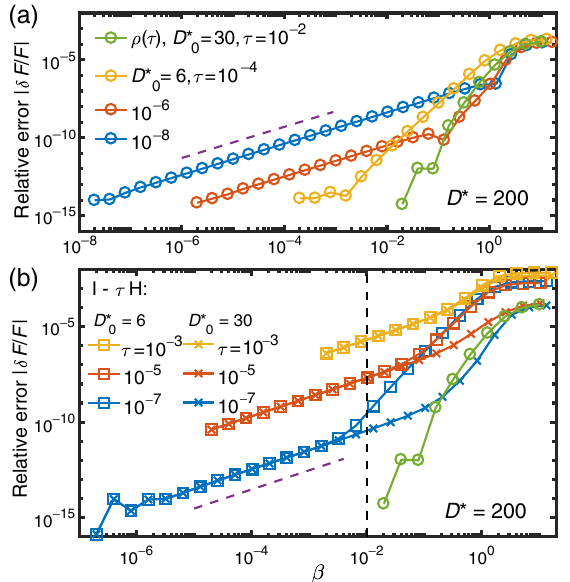
FIG. 16. (a) Relative error of free energy for the Heisenberg model on a 4 × 4 open square lattice ( D (cid:3) H ¼ 6 ), with various initial τ and D (cid:3) 0 values in the XTRG scheme. Here, the ρ ð β ¼ τ 0 Þ is initialized via SETTN [cf. Eq. (7)]. (b) Similar to (a) but using the lowest-order, i.e., linear, expansion of ρ ð τ 0 Þ ¼ I − τ 0 H for the initialization of ρ ð τ 0 Þ instead of SETTN [only the green curve at 10 − 2 uses SETTN and is copied from (a) for direct τ 0 ¼ reference]. Here, we use D (cid:3) ¼ D (cid:3) 0 for all temperatures down to β ¼ 10 − 2 (black dashed line), where we switch to D (cid:3) ¼ 200 . Purple dashed lines indicate linear behavior, i.e., j δ F=F j ∝ β